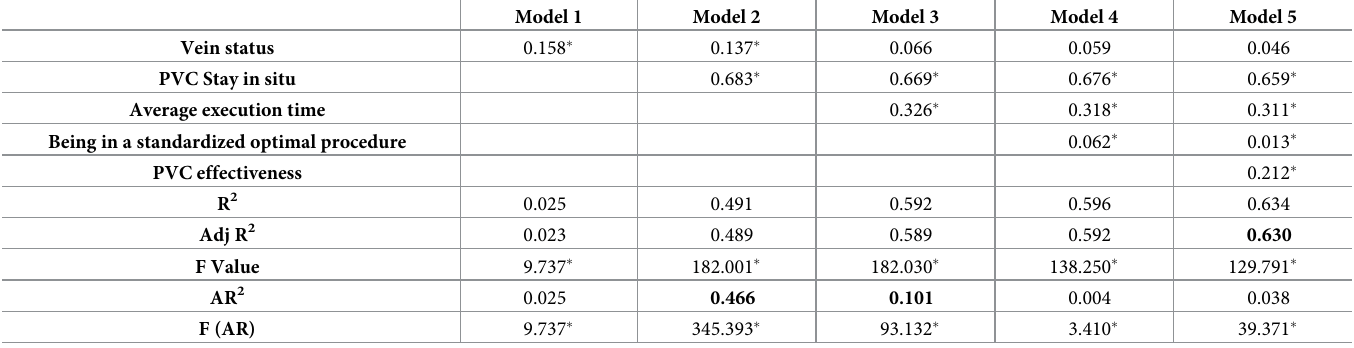
Table 6. Regression model for